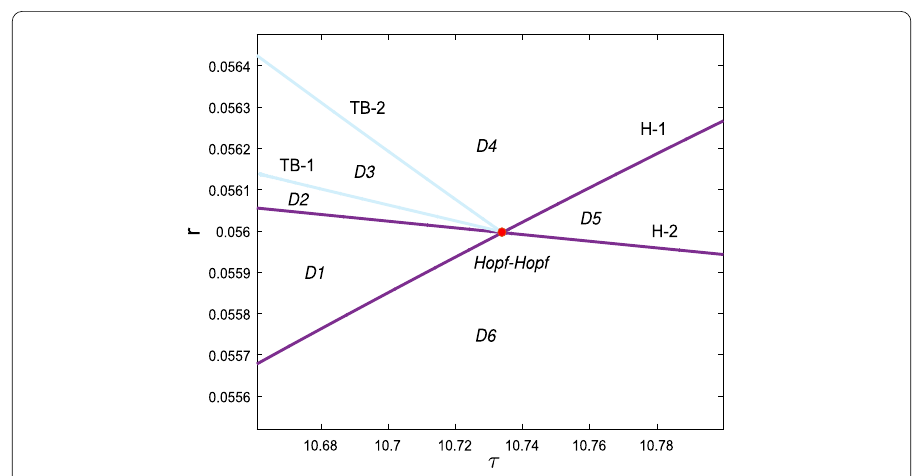
Figure 5 Bifurcation diagram of the Hopf–Hopf point. H-1 and H-2 represent two Hopf bifurcation curves, and their intersection is the Hopf–Hopf bifurcation. There are two torus bifurcation curves originating from the Hopf–Hopf point, TB-1 and TB-2. τ – r plane is divided into six regions, defined as D 1 – D